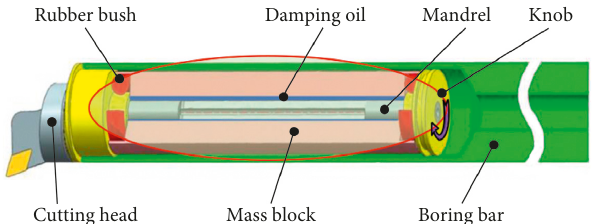
Figure 1: Structure of the boring bar with a variable stiffness DVA.